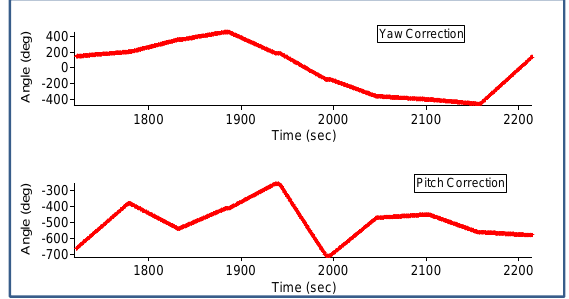
Figure 4. Adjustment results: Piecewise linear time dependent ER-2 corrections, pitch attitude angle and position in the North direction.